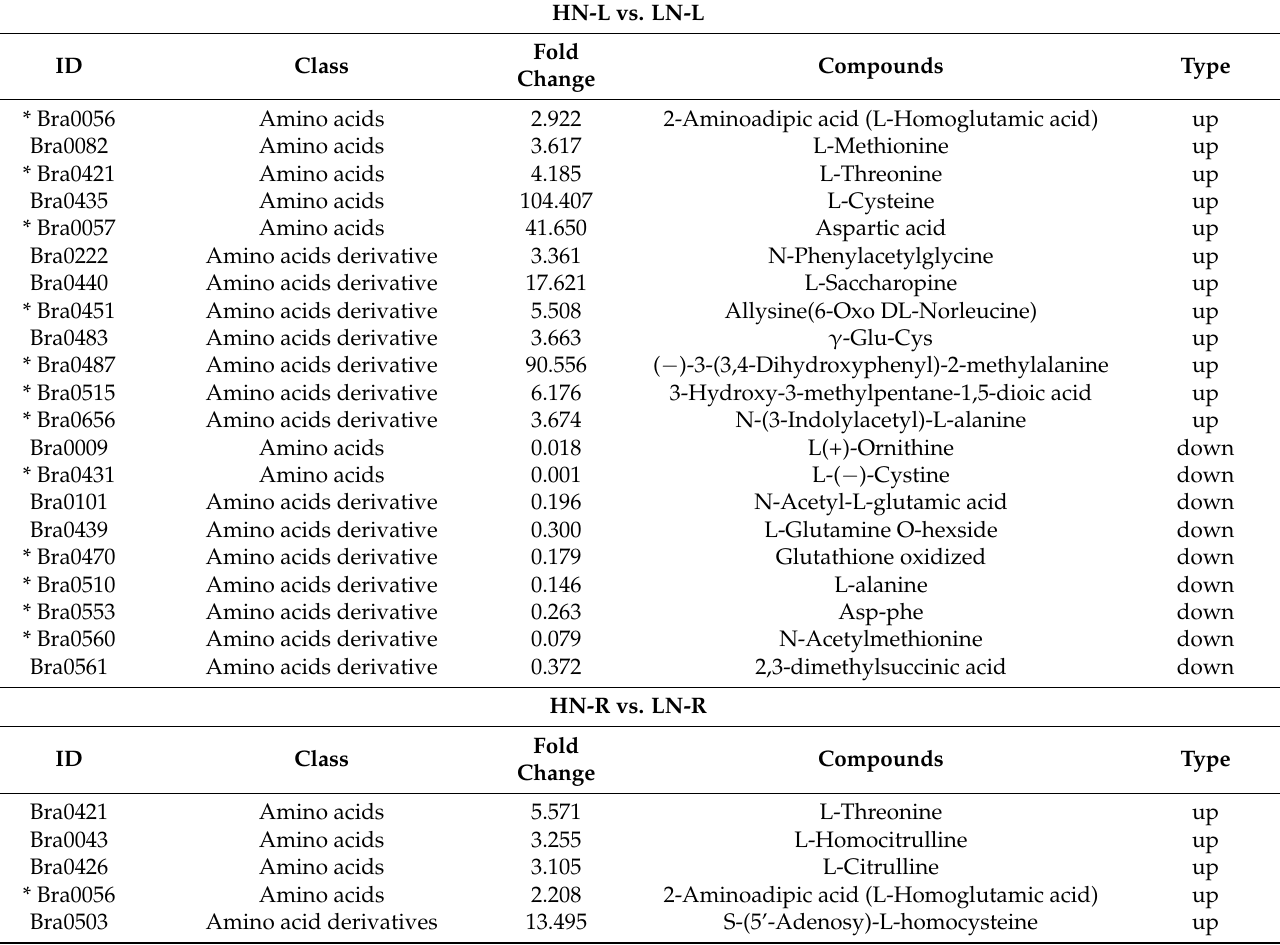
Table 3. Fold change of amino acid metabolites detected in the HN leaf when compared to the LN leaf, and HN root compared to the LN root, respectively. Asterisk marks indicate that the metabolite was detected both in the leaf and